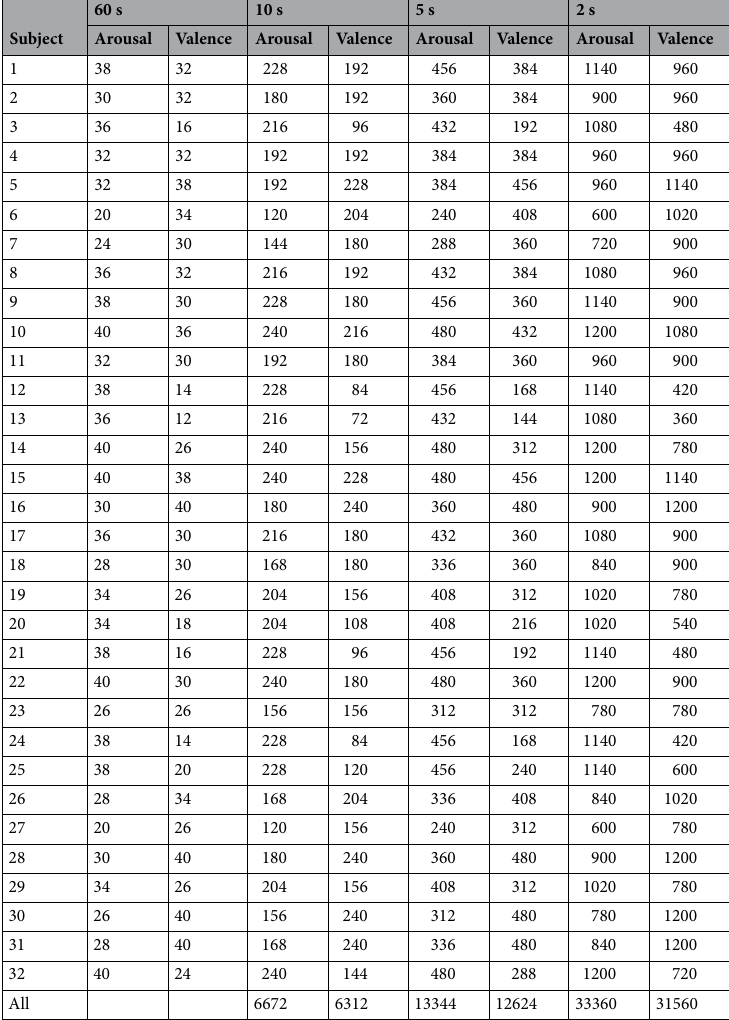
Table 1. Number of instances per subject from the DEAP dataset, using different EEG signal segment sizes.